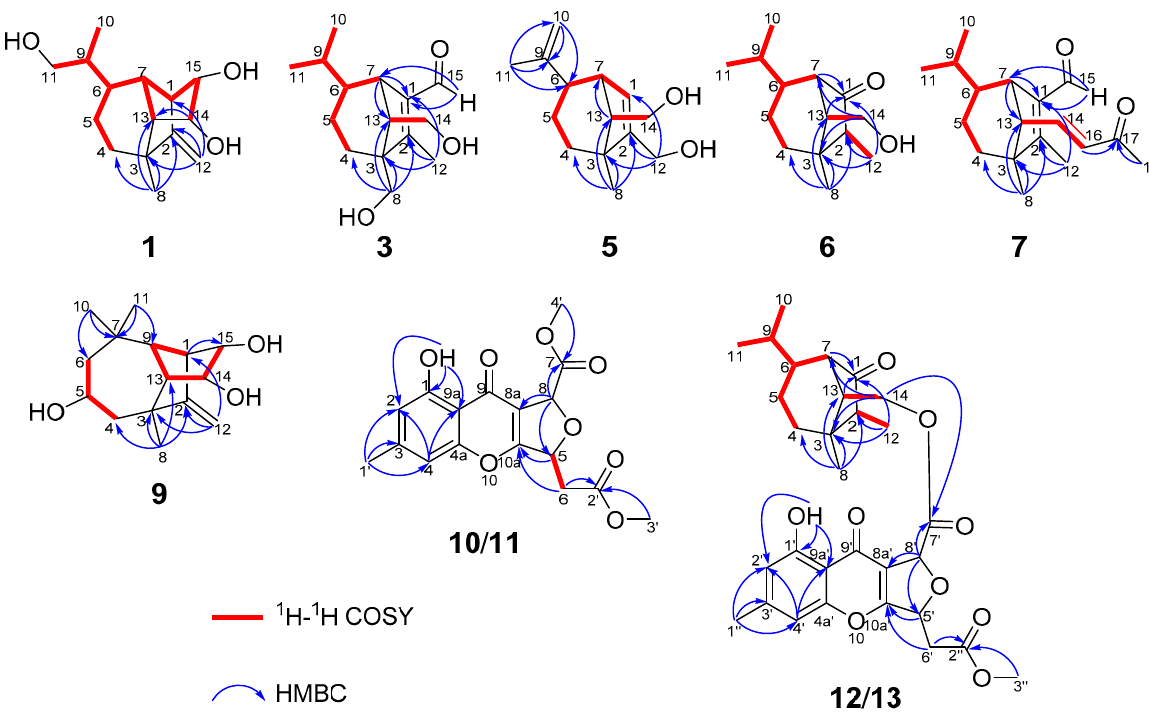
Figure 2. Key 1 H– 1 H COSY and HMBC correlations for 1 , 3 , 5 , 6 , 7 , and 9 – 13 .